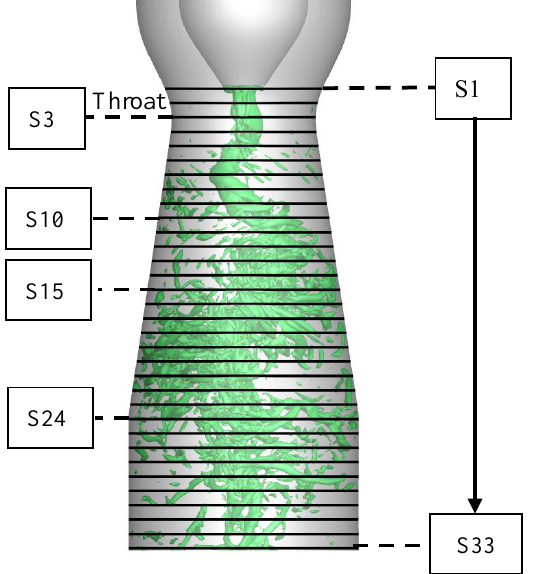
Figure 7. Schematic diagram of different sections of vortex rope in draft tube.